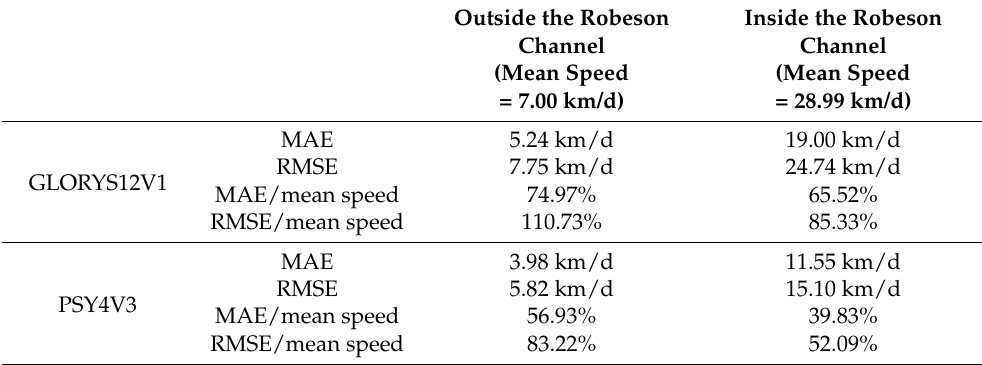
Table 5. Accuracies of each product for the two sub-regions inside and outside the Robeson